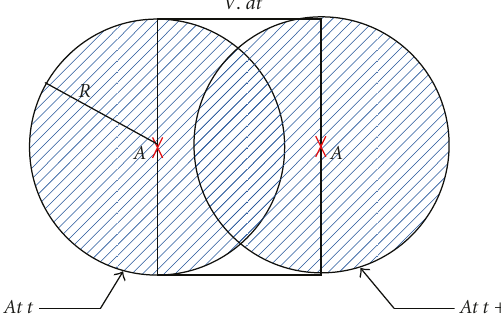
Figure 3: Node Speed Consideration.